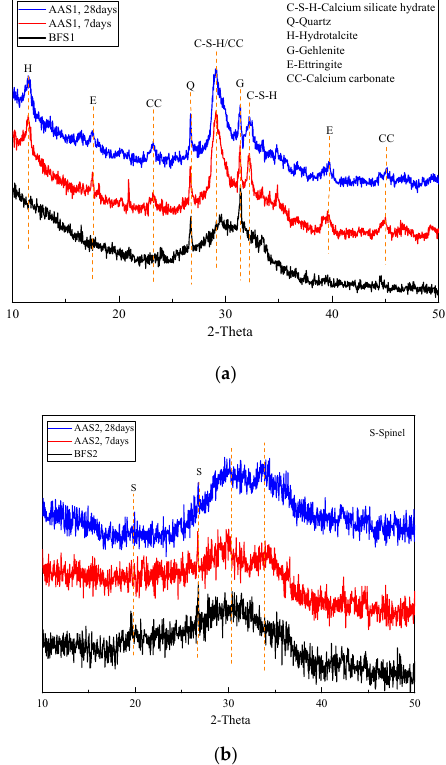
Figure 3. XRD patterns of AAS. ( a ) AAS1 and ( b ) AAS2.